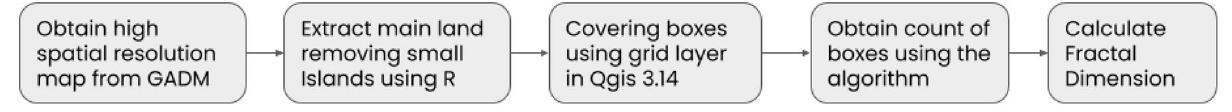
Figure 3. Flow chart of the box-counting method in our